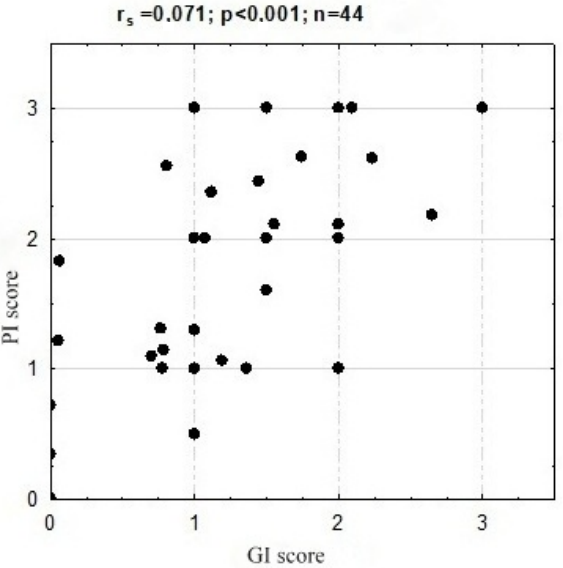
Figure 2. Spearman rank order correlation.